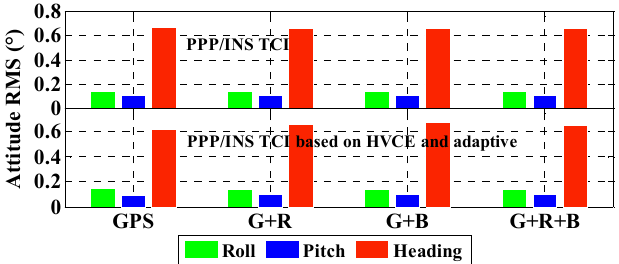
Figure 11. RMS of attitude offsets from the PPP/INS tightly coupled integration mode without ( top ) and with the HVCE based adaptive scheme ( bottom ) using GPS, G + R, G + B, and G + R + B GNSS data.